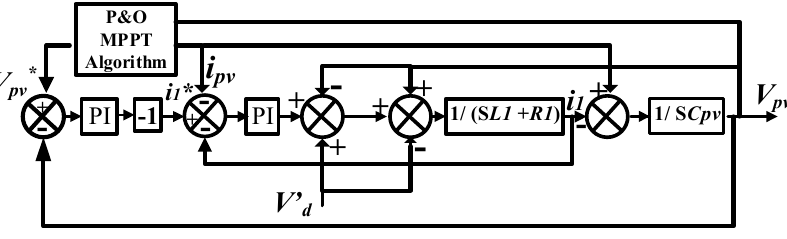
Figure 5. Block diagram for the boost converter control.